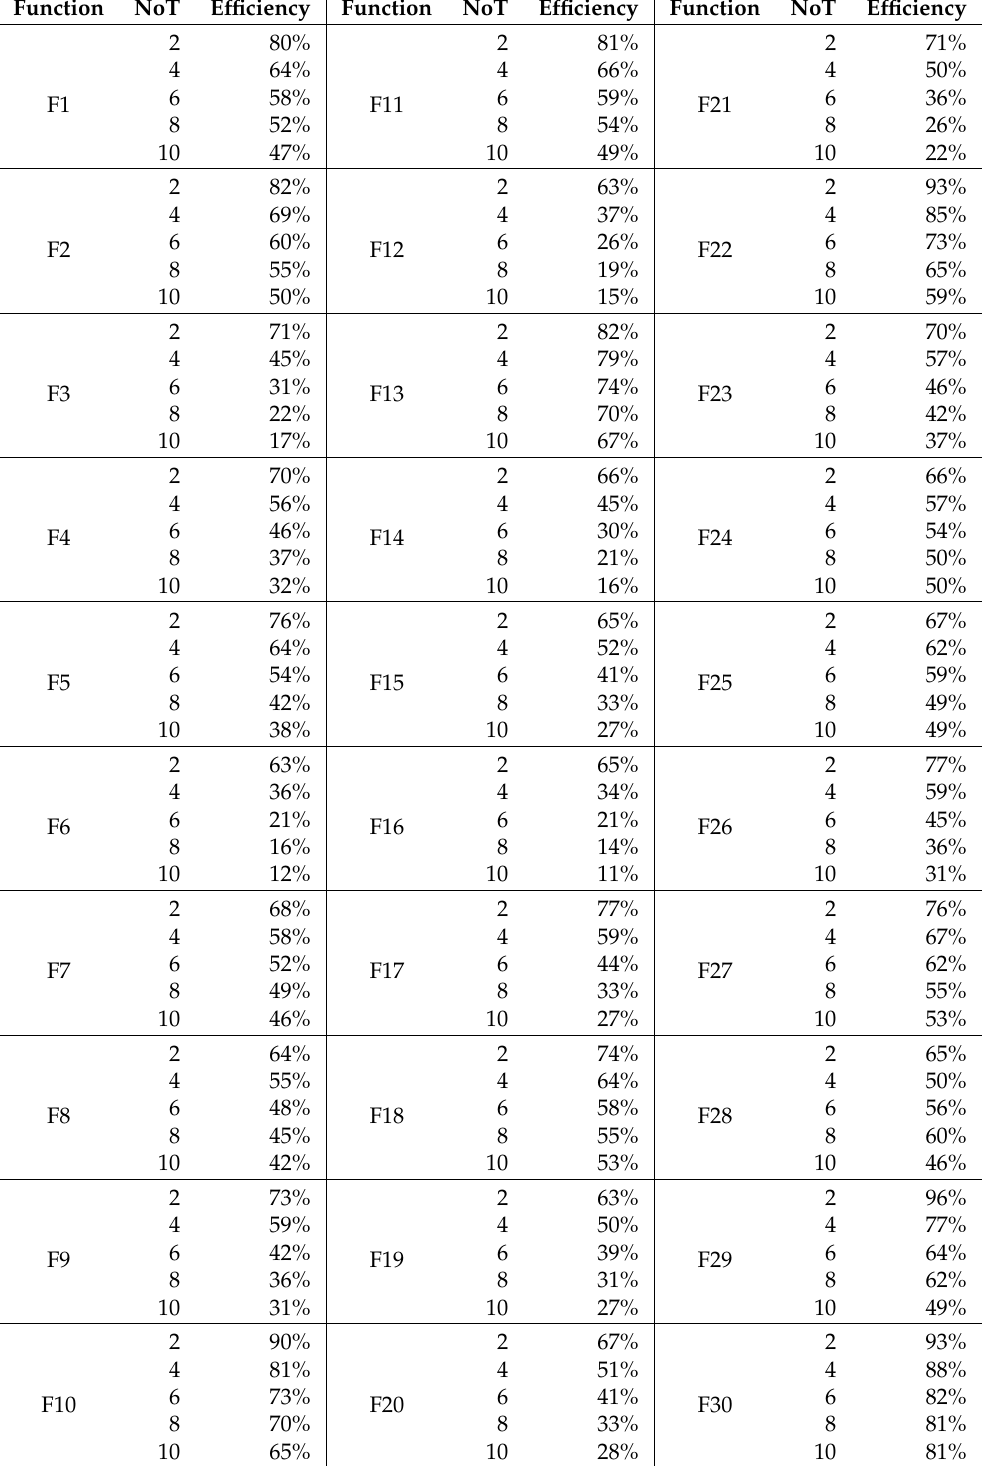
Table 3. Efficiencies for SPG_TLBO, Runs = 30, Population size = 240, Iterations =